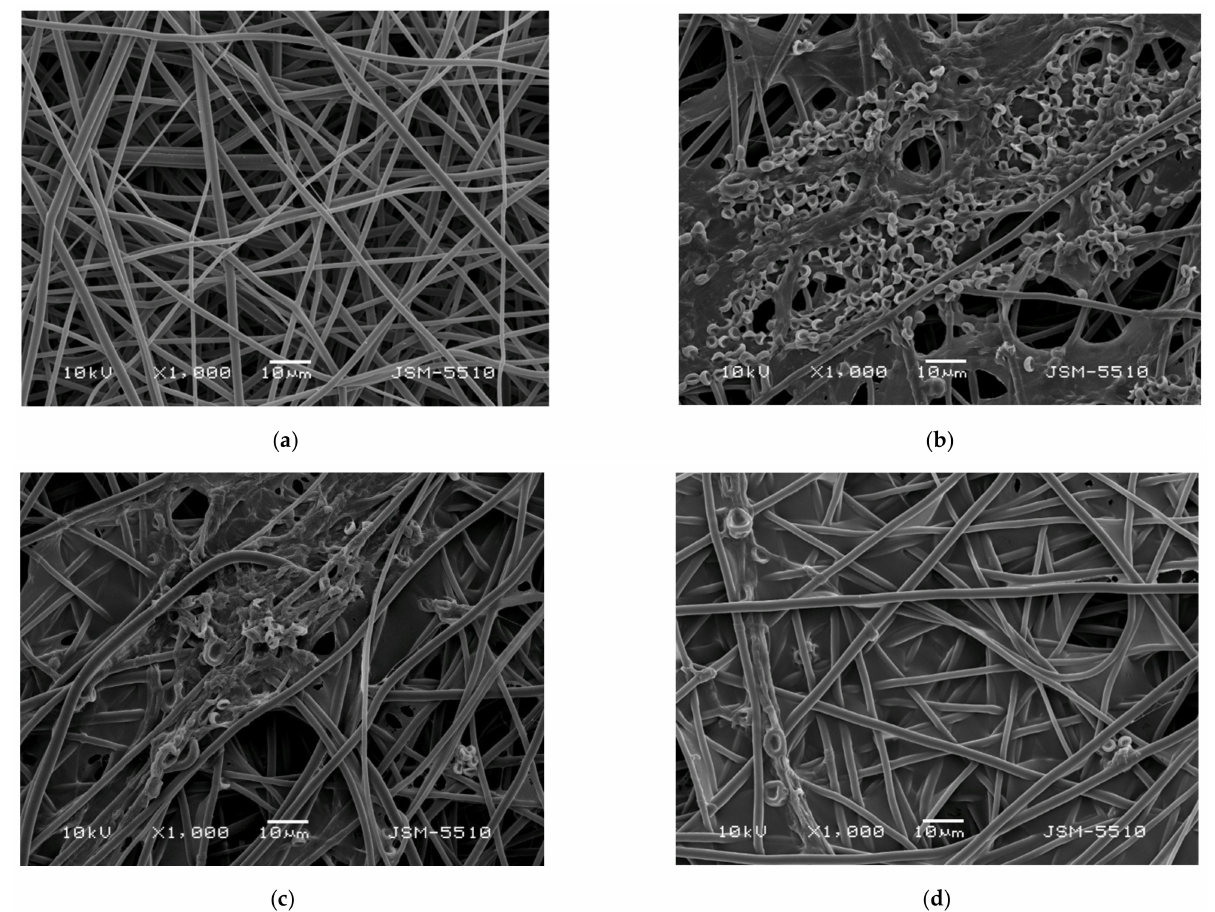
Figure 1. Representative SEM images of ( a ) a PLLA mat, ( b ) a PLLA mat coated with oligochitosan/ T. asperellum spores, ( c ) a PLLA mat coated with LMW chitosan/ T. asperellum spores and ( d ) a PLLA mat coated with HMW chitosan/ T. asperellum spores; magnification ×